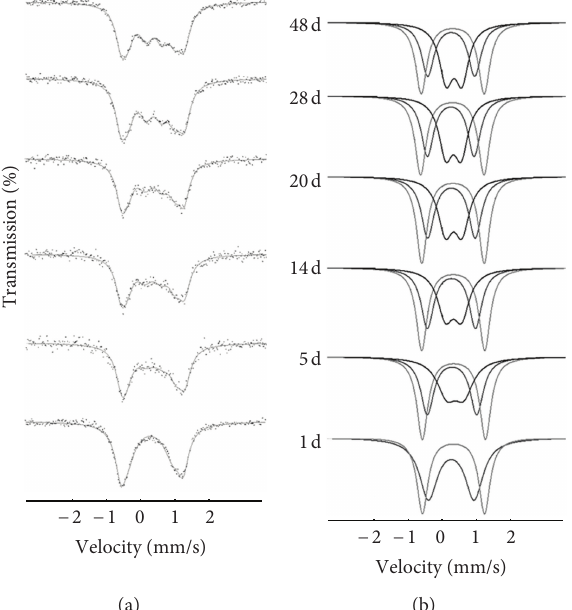
F 7: Mössbauer spectra of cement paste with addition of �y ash PC1FA at different ages of